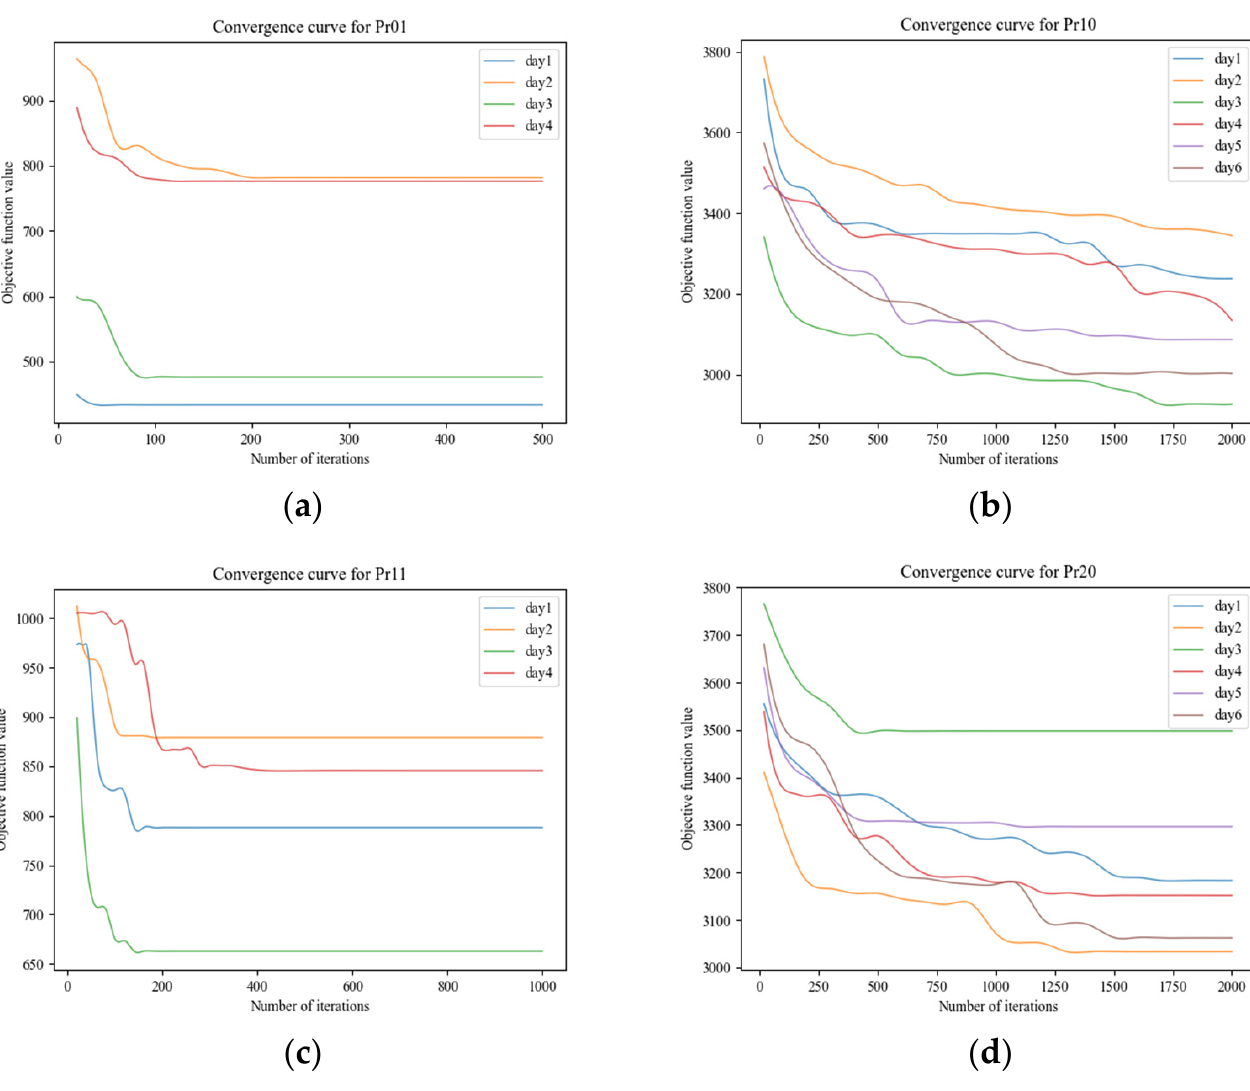
Figure 8. Convergence curves of IVNS for four instances. ( a ) Convergence curve for Pr01. ( b ) Con- vergence curve for Pr10. ( c ) Convergence curve for Pr11. ( d ) Convergence curve for Pr20.